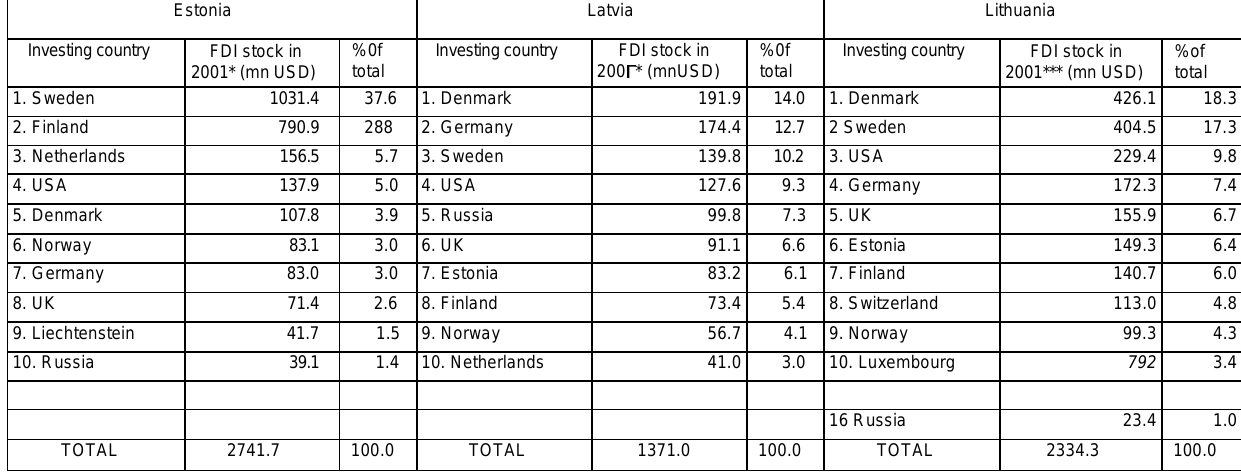
Investing country FDI stock in %0f 200 * (mnUSD) total (cid:0)